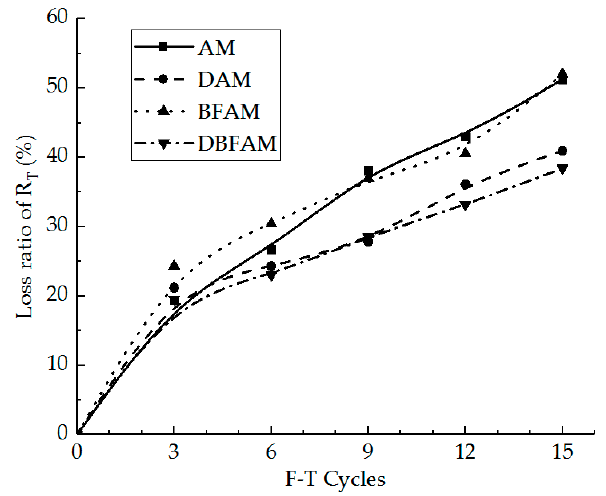
Figure 6. Loss ratio of IDT strength under F–T cycles.